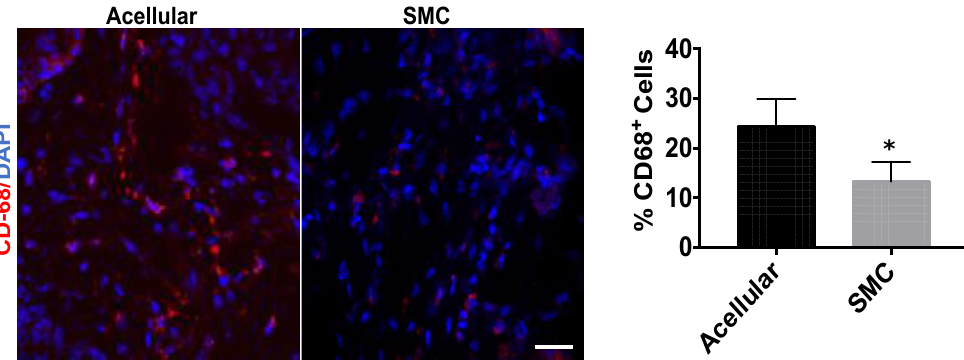
Figure 10. hiPSC-VSMC-mediated modulation of macrophages in vivo. In vivo, the anti-inflammatory role of hiPSC-VSMCs on macrophages was characterized. Immunostaining of the wound site with CD68 detecting the macrophages and the graph showing the number of macrophages for wounds treated with acellular and hiPSC-VSMC scaffolds, ( n = 4, hiPSC-VSMC vs. Acellular p < 0.02). Dapi was used to stain nuclei. Scale bar represents 50 µm. Statistical analysis was performed using the Student t -test. * denotes statistical significance.